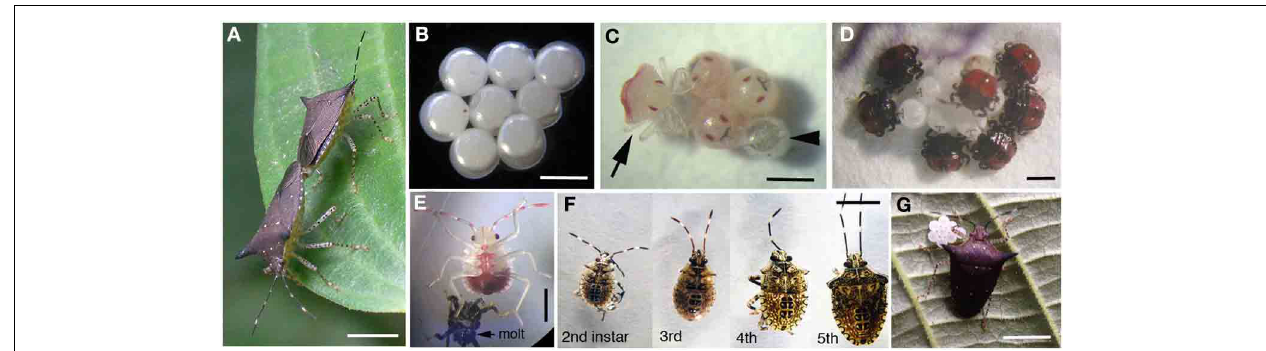
FIGURE 11 | Captive rearing of Sibaria englemani . (A) Mating adults with female at bottom left. Scale, 5mm (B) Eggs oviposited in mesh cages. Scale, 1mm (C) Newly hatched nymph (arrow), with empty egg at arrowhead. Scale,